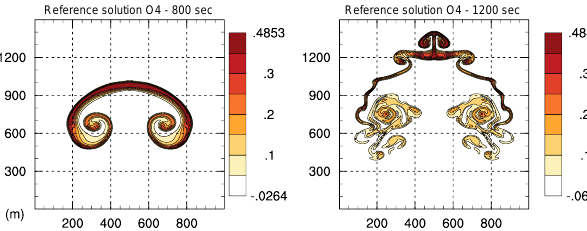
Figure 17. Rising Robert bubble potential temperature reference solution at vertical order 4. Reference resolution (cid:49)x = 5 m and (cid:49)z = 5m. Flow at 800 and 1200s. Contour interval: 0 . 05K.